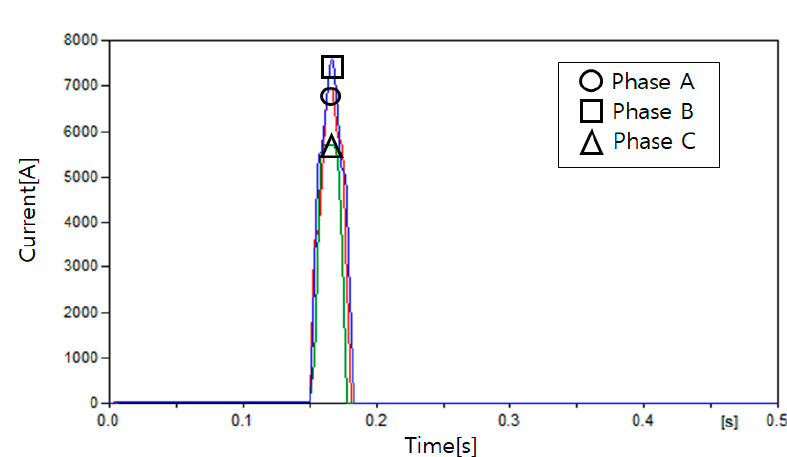
Figure 16. Fault location in Case 4. Energies 2020 , 13 , x FOR PEER REVIEW